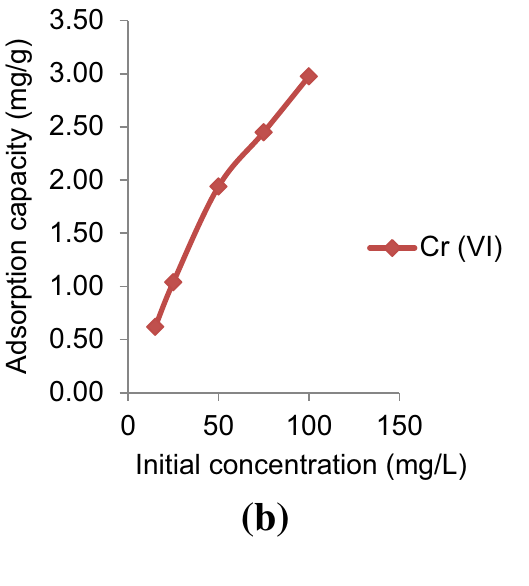
Fig. 5 Effect of initial concentration on the adsorption of Cr(VI)